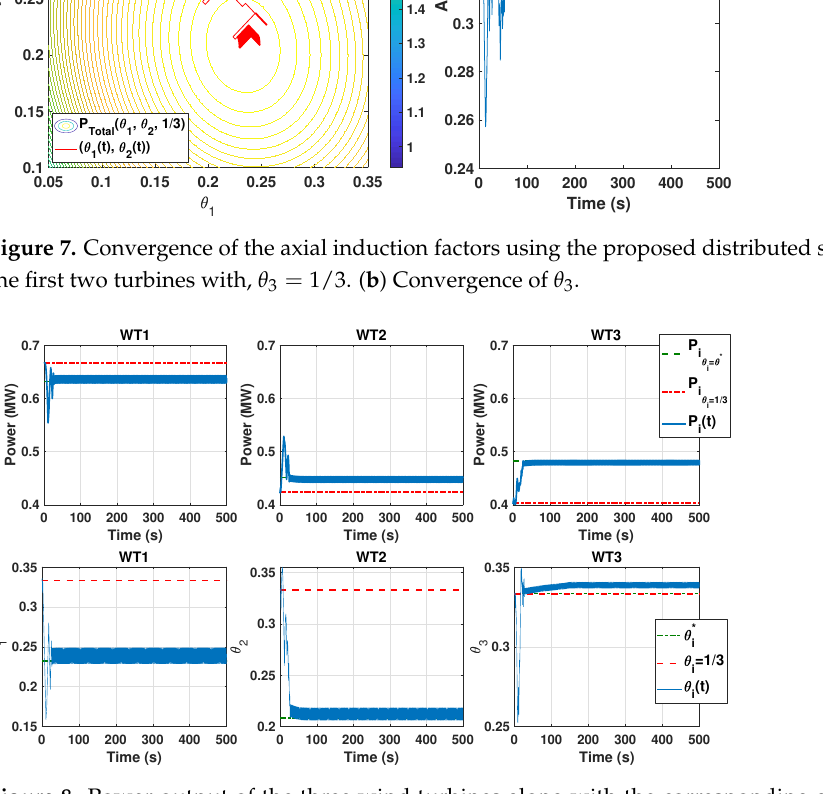
Figure 8. Power output of the three wind turbines along with the corresponding axial induction factor generated by the proposed